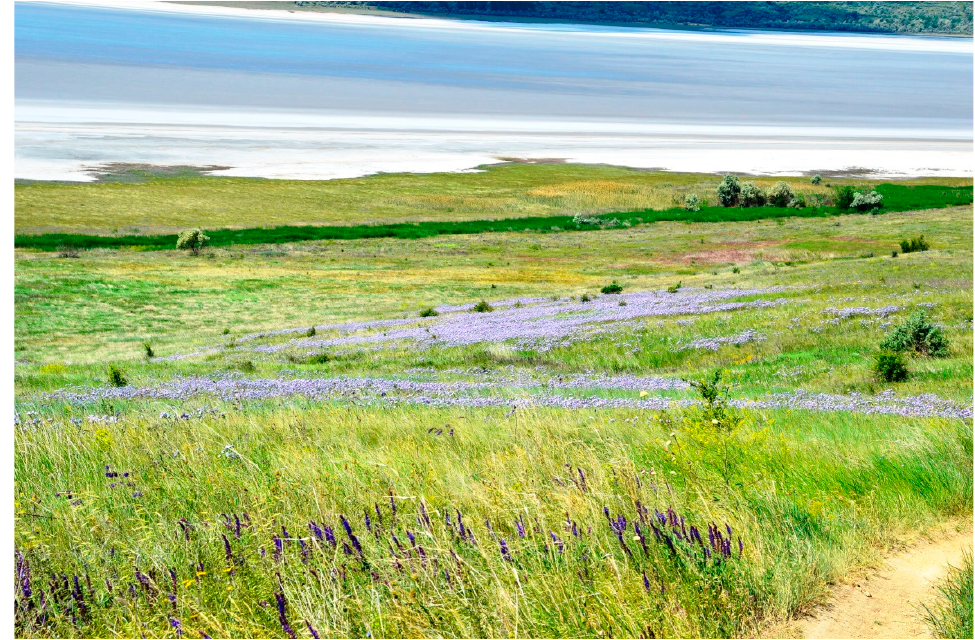
Figure 5. General view of the gully (opposite of Stara Emetivka village).